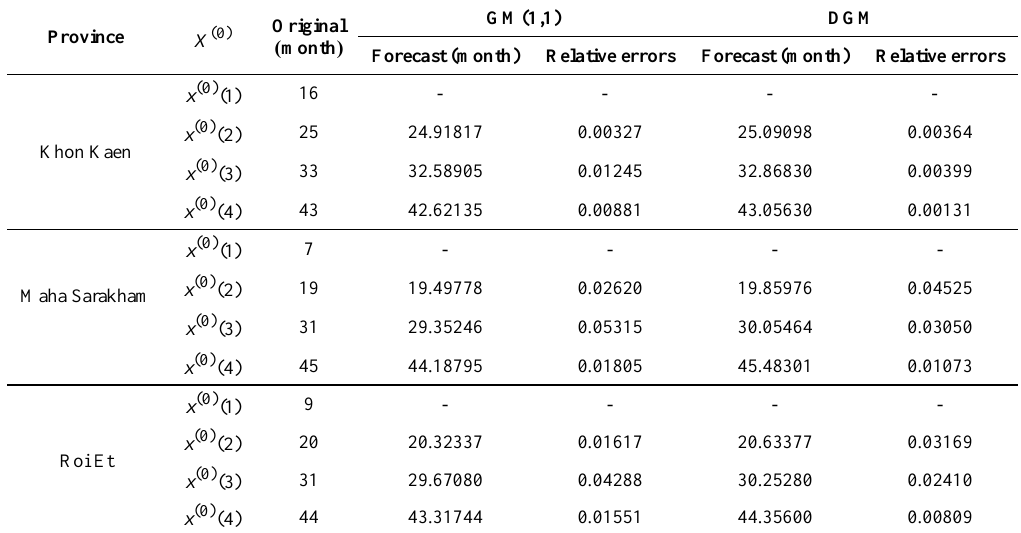
Table 4. The values of forecasting and relative errors of GM(1,1) and DGM.